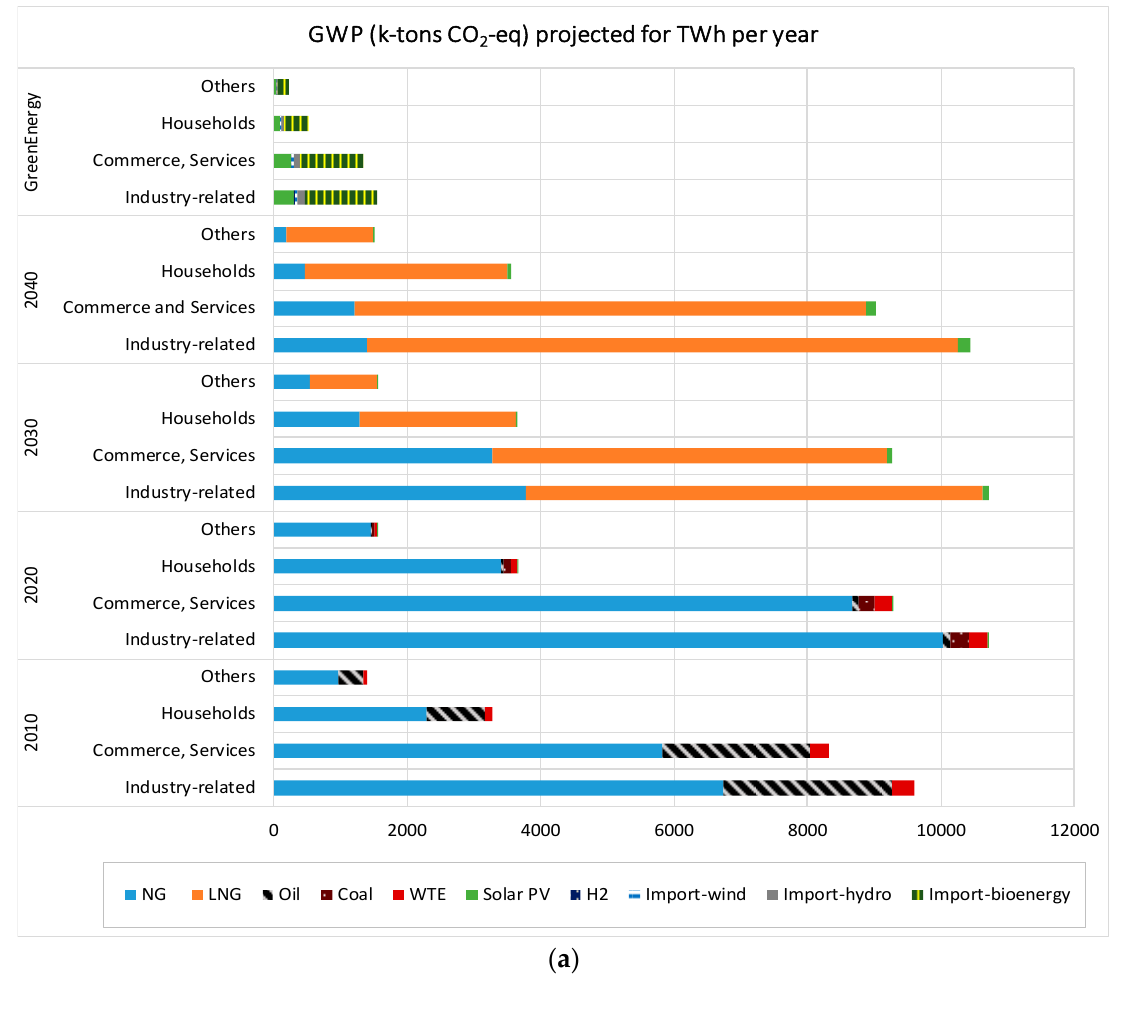
Figure 3. Preliminary assessment: environmental impacts.